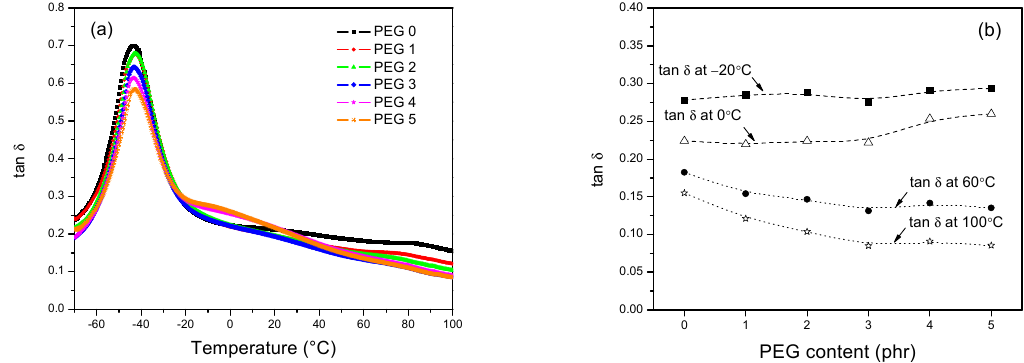
Figure 13. ( a ) Temperature dependence of tan δ for the indicated vulcanizates and ( b ) the values of tan δ at different temperatures.